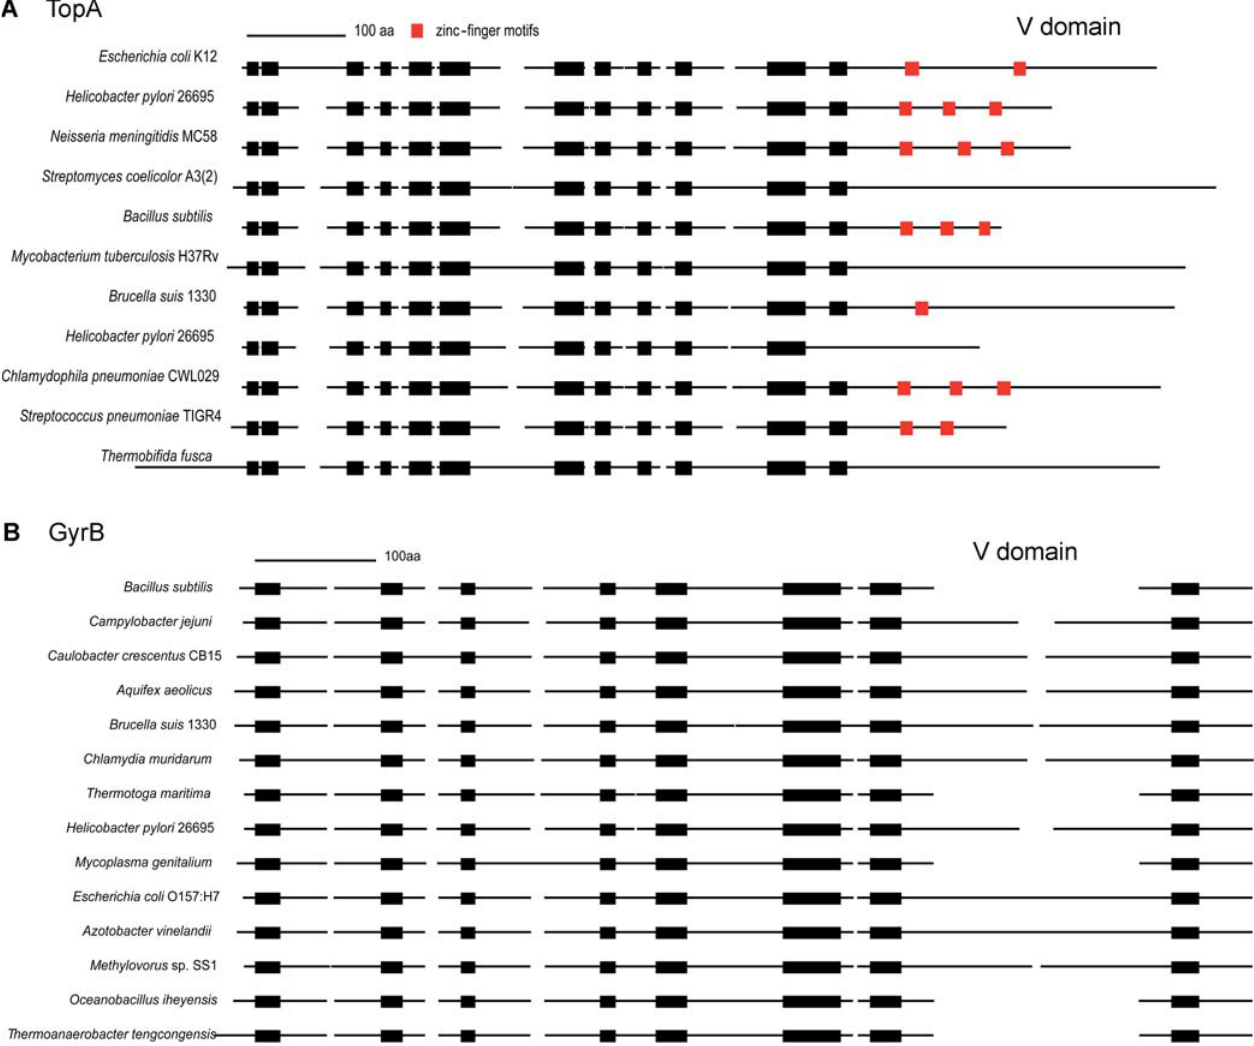
Figure 4. Schematic Alignment of TopA and GyrB (A) TopA. (B) GyrB. Each line represents a sequence. Black boxes indicate the conserved blocks from the BLOCKS database and are aligned correspondingly. Red boxes in (A) are the zinc-finger motifs reported by Pfam. Notice that the number of occurrences of this motif varies and that there are several sequences without this motif in the C-terminal. The lines between the boxes are the variable sequences that cannot be aligned. Variable domains are labeled in the figure. DOI: